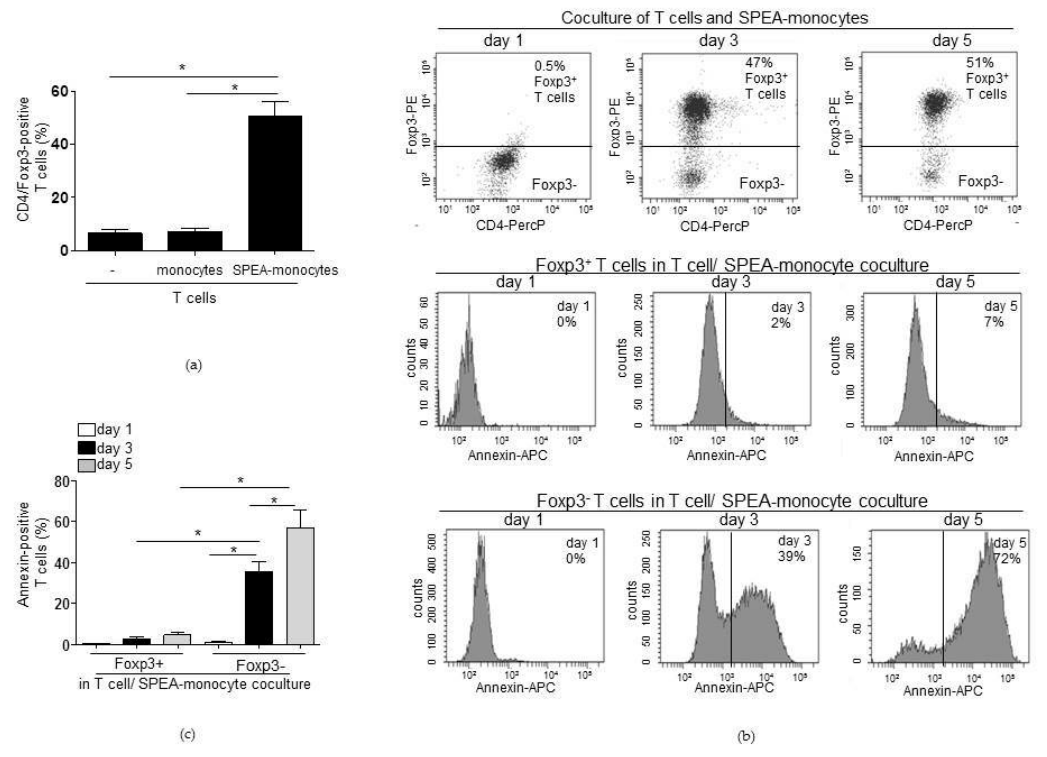
Figure 3. SPEA-monocytes induce apoptosis of Foxp3-negative T cells. ( a ) CD4 + T cells were cultured with unstimulated monocytes or SPEA-monocytes for five days. Cells were stained with anti-CD4-PercP and anti-Foxp3-PE and analyzed for double-positive cells on a FACSCanto. Y -axes: Percentage of CD4 / Foxp3-positive Tregs. ( b ) CD4 + T cells were cocultured with allogeneic SPEA-monocytes for the indicated timepoints (one, three, or five days). Cells were stained with anti-CD4-PercP, anti-Foxp3-PE, and annexin-APC and analyzed on a FACSCanto. After gating for Foxp3 + and Foxp3 − cells, the fluorescent annexin signal was detected in both populations. Upper row: dot blot of Foxp3-PE / CD4-PercP double stain. Middle row: histogram of annexin-APC signal on gated Foxp3 + cells. Lower row: histogram of annexin-APC signal on gated Foxp3 − cells. ( c ) Shown is the percentage of annexin-positive T cells from ( b ) and two more experiments. White column: day 1. Black columns: day 3. Grey columns: day 5. ( a , c ): Columns: mean of three di ff erent donors / experiments ( n = 3) + SD as error bars. Statistical analysis: the comparison of two data groups was analyzed by Mann–Whitney U test with * p ≤ 0.05. Line above the columns: compared groups. Kruskal–Wallis: ( a ) number of groups: 3; p -value 0.0201; sum value, *; ( b ) number of groups: 6; p -value 0.0099; sum value, **, the medians of ( a , b ) vary significantly ( p < 0.05).